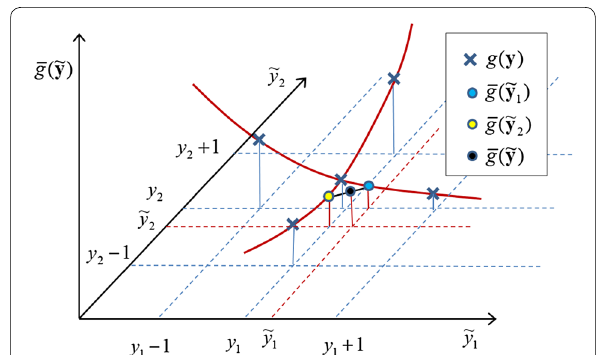
Fig. 5 Piecewise quadratic interpolation with two integer variables.